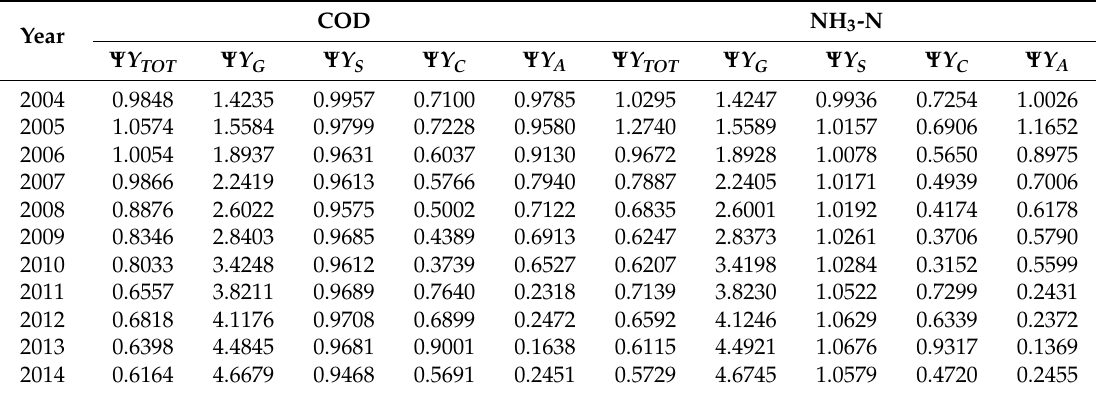
Table A4. Cumulative decomposition results converted from the multiplicative results (2003 =